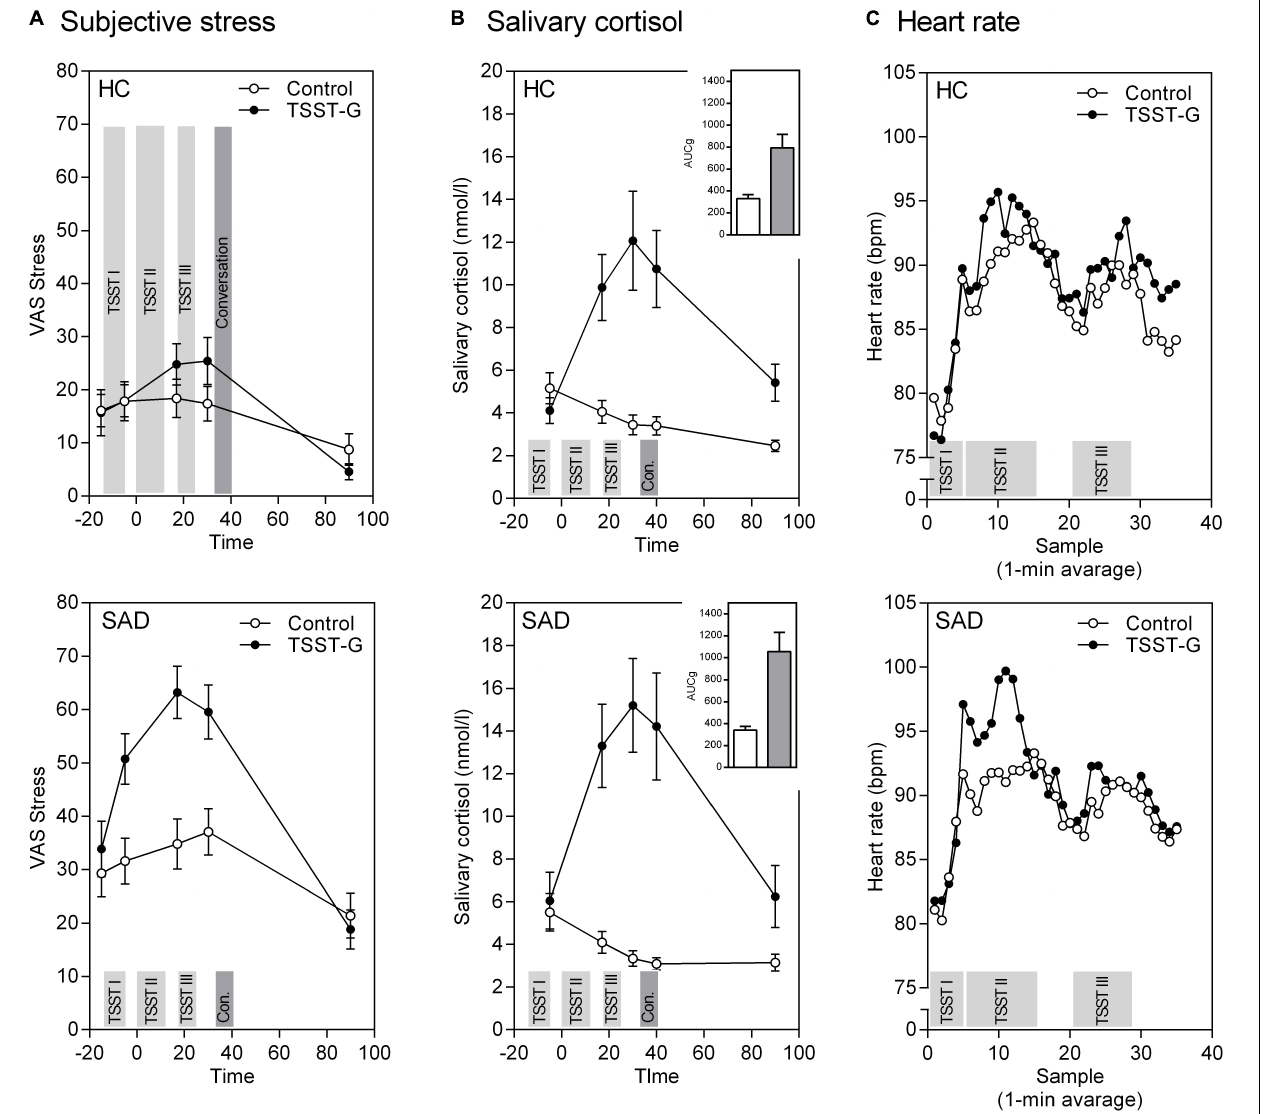
FIGURE 2 | Mean ( ± SEM) of the psychobiological stress response in healthy controls (HC) and participants with SAD to the TSST-G and the control condition. (A) Subjective stress on a VAS, (B) free salivary cortisol concentration with Area-Under-the-Curve (AUC), and (C) heart rate over the course of the experiment. The experiment’s different phases are highlighted as bars: 5 min Anticipation (TSST I), Speech/Reading (TSST II), Mental arithmetic/Counting (TSST III), and